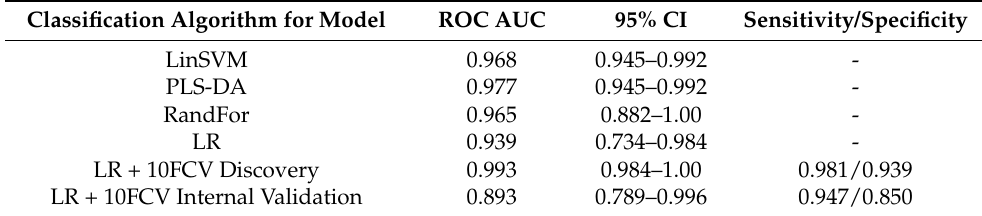
Table 3. Classification results for the convergent 6-metabolite subacute mTBI panel. Classification Algorithm for Model